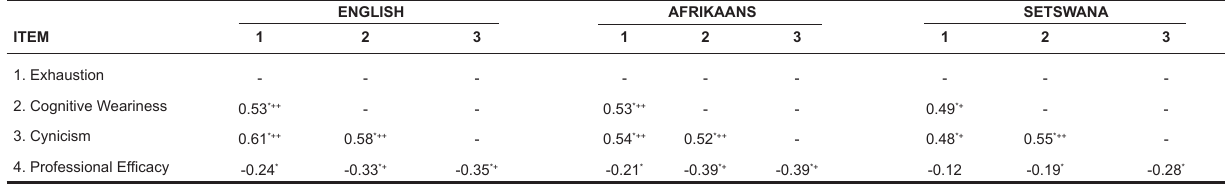
TABLE 6 Pearson correlations of the adapted and translated